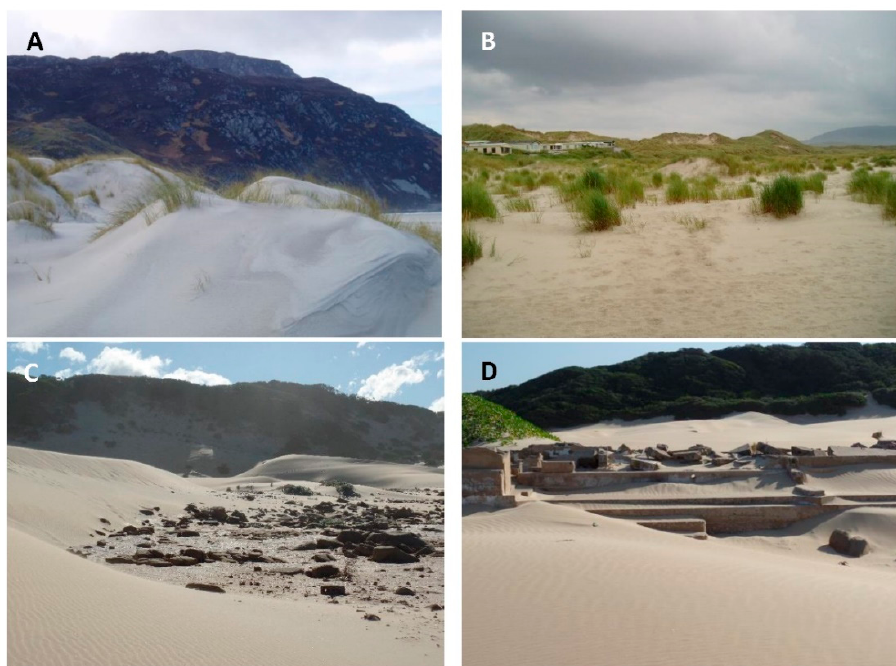
Figure 3. Examples of sand within beach systems. ( A ) Embryo and ( B ) vegetated dunes in the supratidal zone, northwest Ireland; ( C ) oblique dunes migrating over a deflated interdune hollow and ( D ) migrating sand sheets variously burying and then exhuming the foundations of a former beach house, both at Eastern Cape coast, South Africa (photos: author).